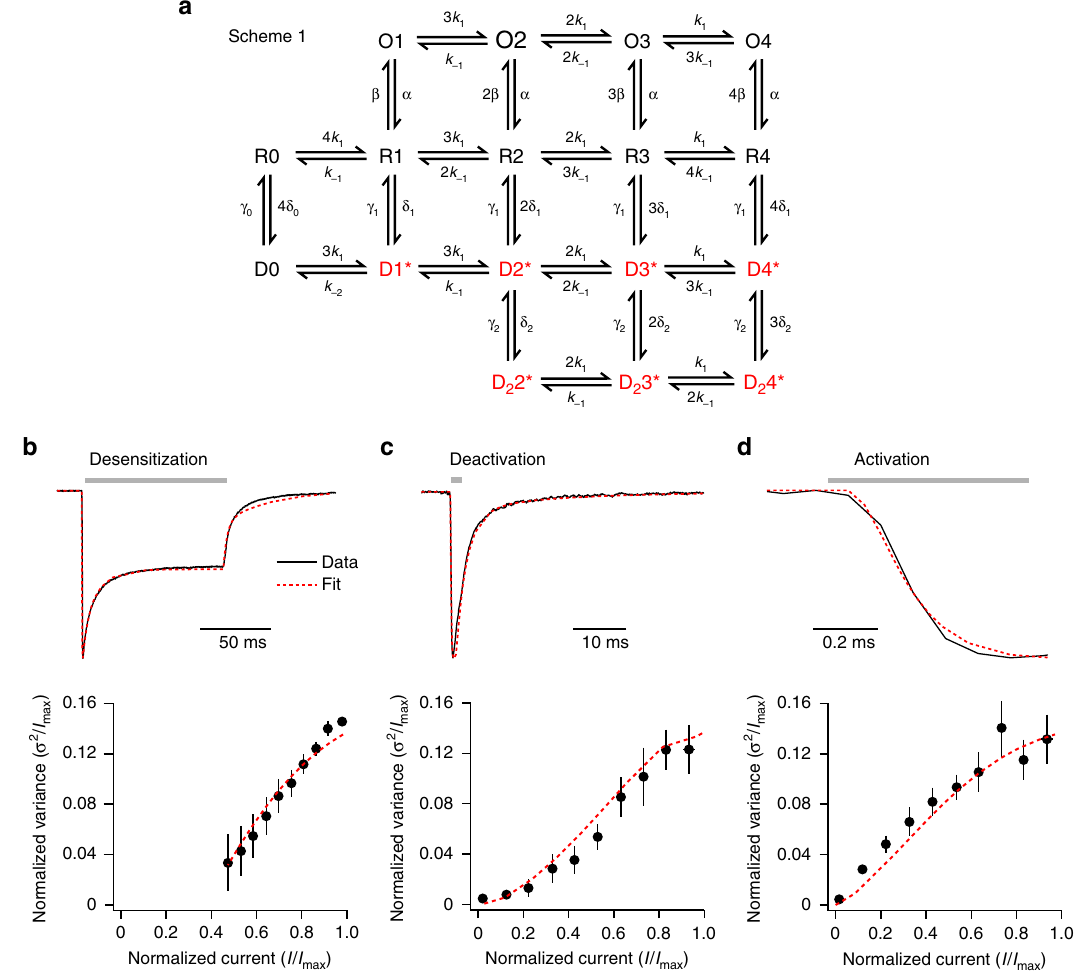
Fig. 5 A kinetic scheme including conducting desensitized states can mimic GluA2(R)/ γ -2 behavior. a Scheme 1 is a modi fi ed form of a previously proposed kinetic model 25,44 . States which can conduct are red. Open states (O1 – O4) and occupied desensitized states (D1* – D4*, D 2 2* – D 2 4*) have independent conductances that are occupancy-dependent. b – d Global averaged GluA2(R)/ γ -2 records (top) and variance data (bottom) for desensitization, deactivation, and activation (10 mM glutamate — gray bars). Using a single set of rate constants and conductances, the model closely mimics all six measures (dashed red lines): k 1 = 1.3 × 10 6 M – 1 s – 1 , k − 1 = 350 s – 1 , α = 3100 s – 1 , β = 1000 s – 1 , γ 1 = 88 s – 1 , δ 1 = 110 s – 1 , γ 2 = 36 s – 1 , δ 2 = 39 s – 1 ,